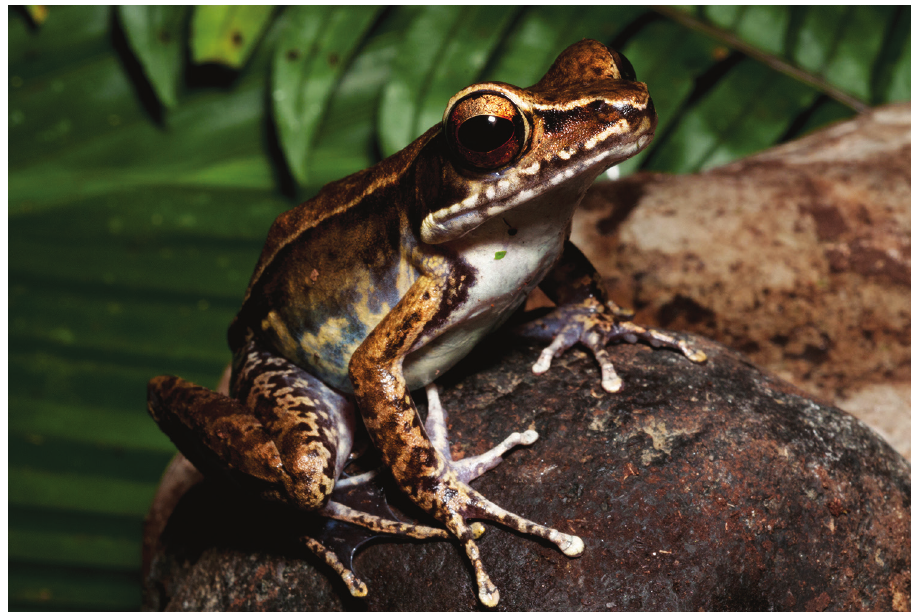
Figure 25. Pulchrana grandocula female (KU333633) from Mt. Lumot, Municipality of Gingoog City, Misamis Oriental Province. Photo: